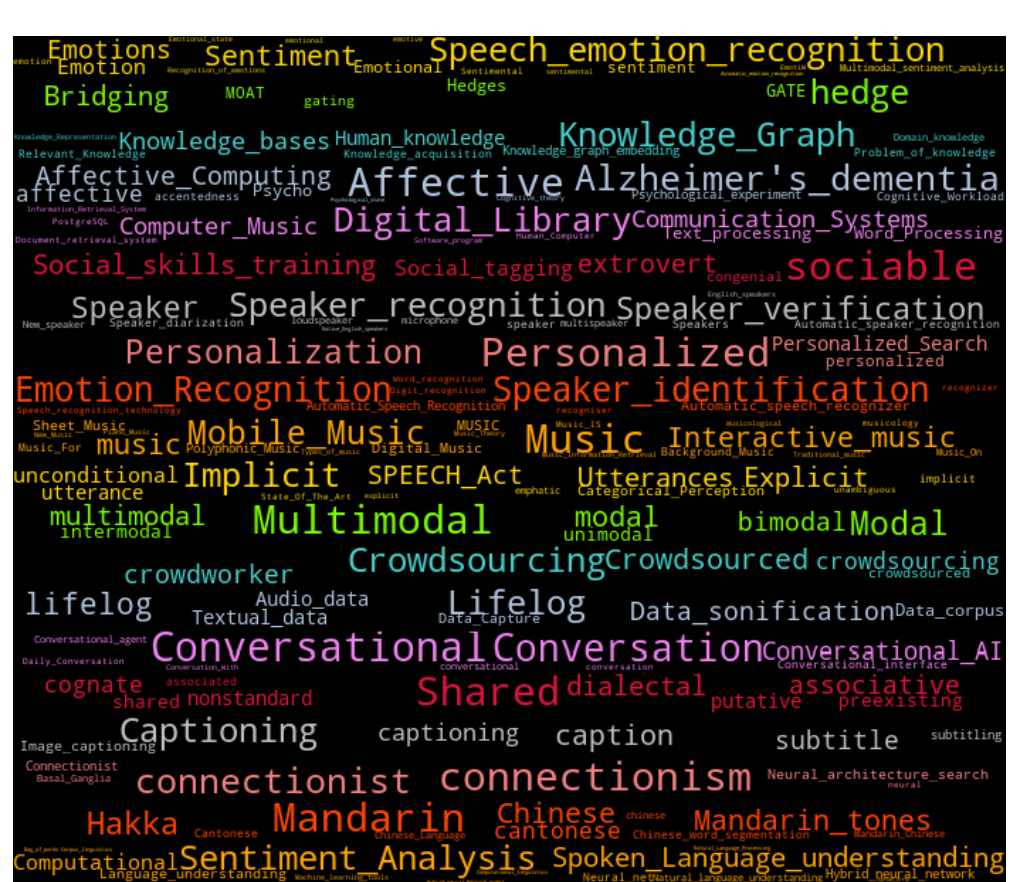
Figure 3. Stratified word cloud for one of the topic communities of the human-computer interactions corpus. It can be interpreted as the topic natural language processing